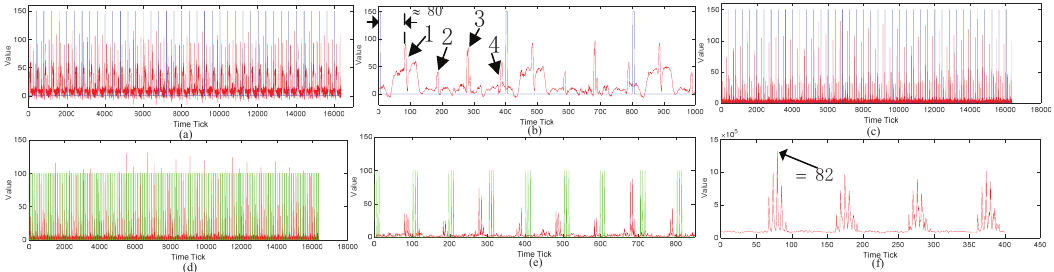
Figure 5. Implementation of the cross-correlation-based automatic locating method. ( a ) the original waveform; ( b ) the zoomed in first two periods of ( a ); ( c ) the calculated I (cid:48) curve combining the auxiliary shape function wave; ( e ) the zoomed in first two periods of ( d ); ( f ) the calculated cross-correlation results.